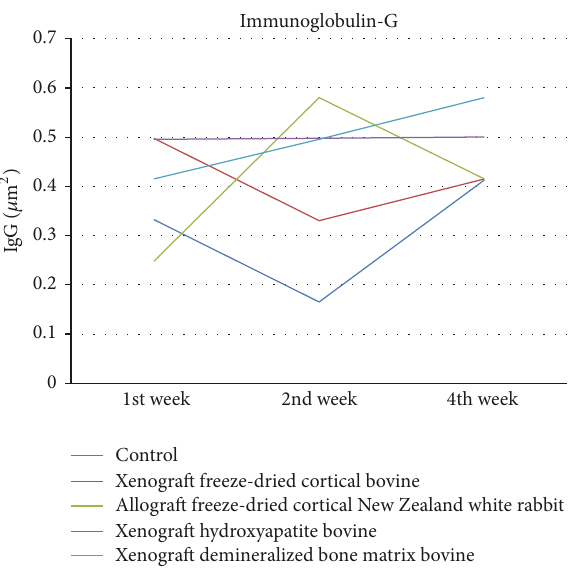
Figure 7: Evaluation of fibrous tissue width ( 𝜇 ).